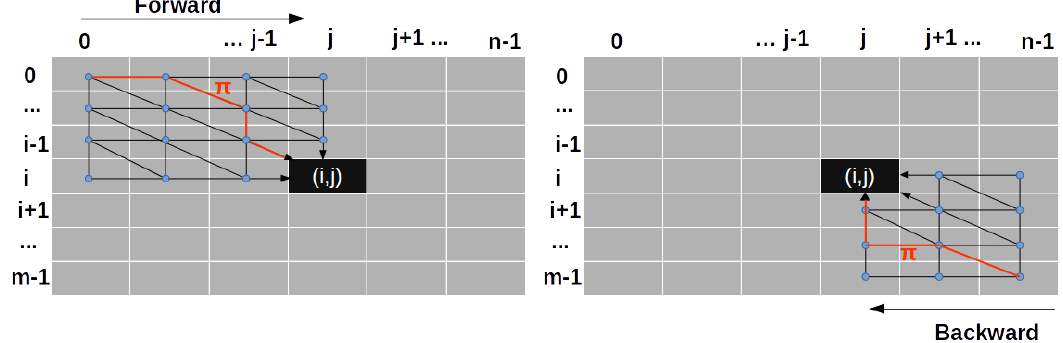
Figure 3. The forward ( left ) and backward ( right ) alignment kernel matrices.